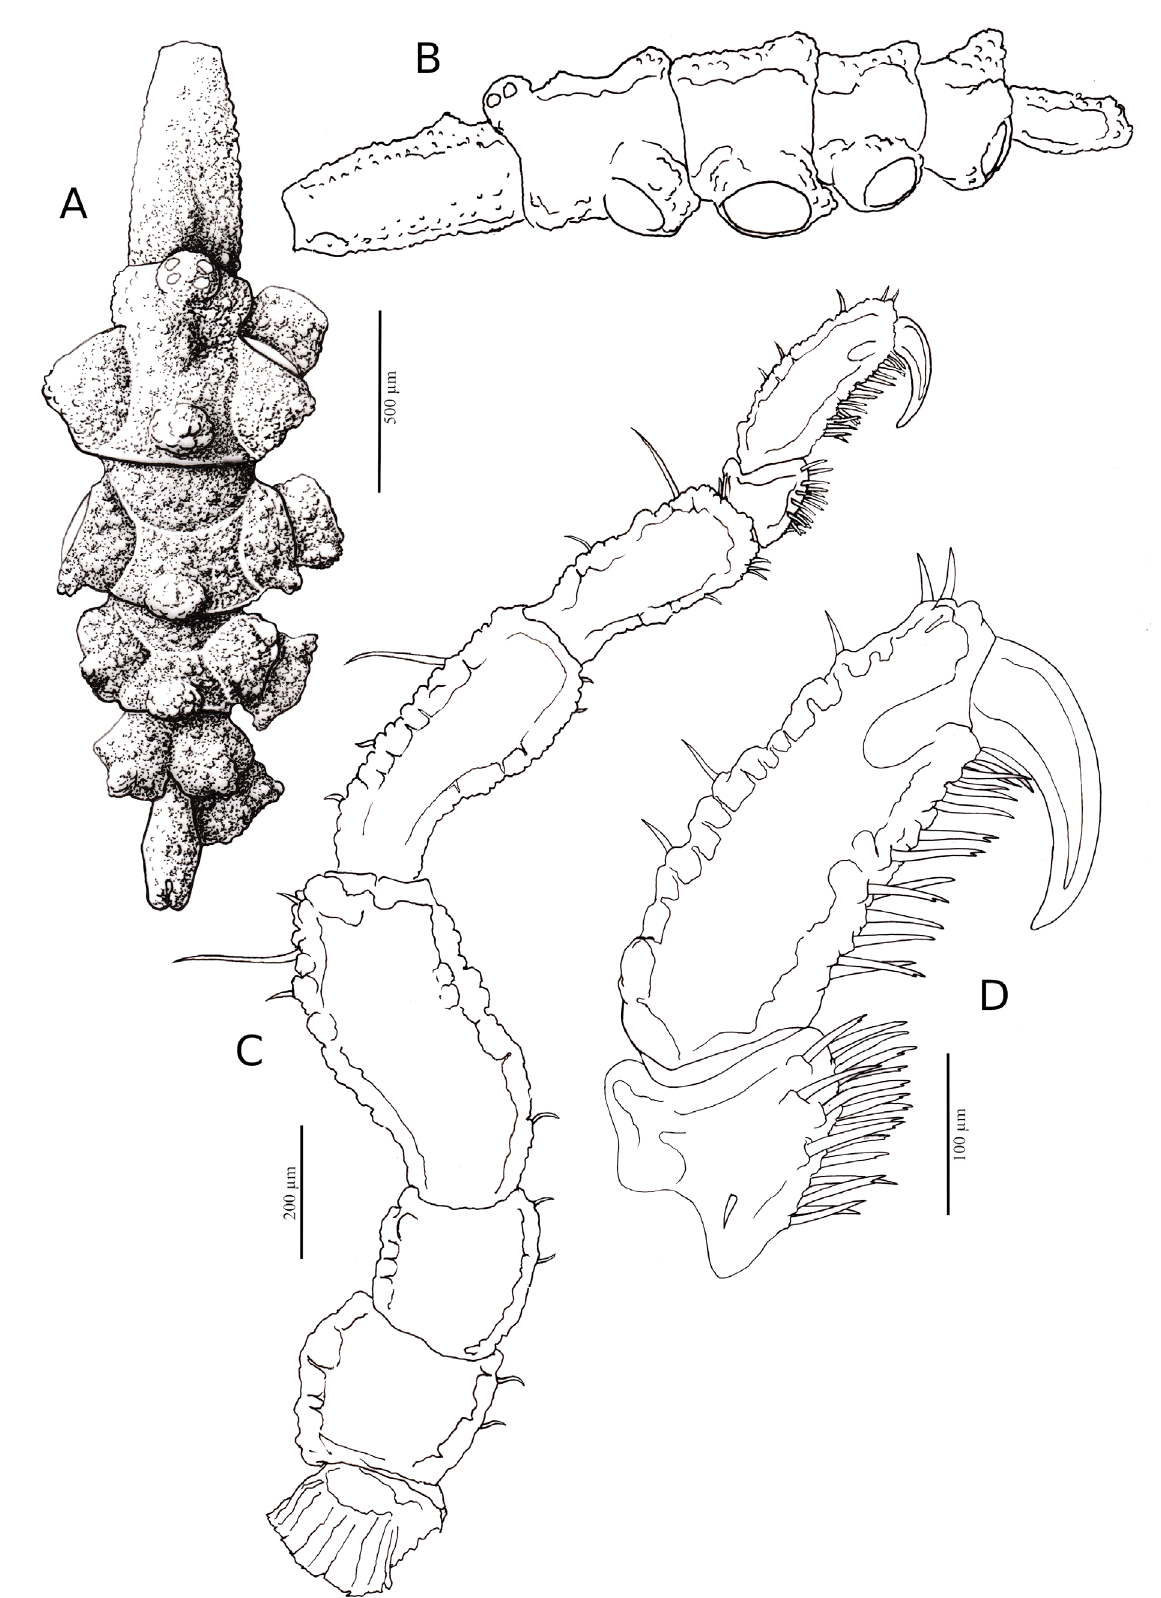
Fig. 29. Pycnogonum cf. ornans Stock, 1992, ♀, MNHN-IU-2016-1064. A . Body, dorsal view. B . Body, lateral view (same scale as A). C . First leg. D . Tarsus and propodus of first